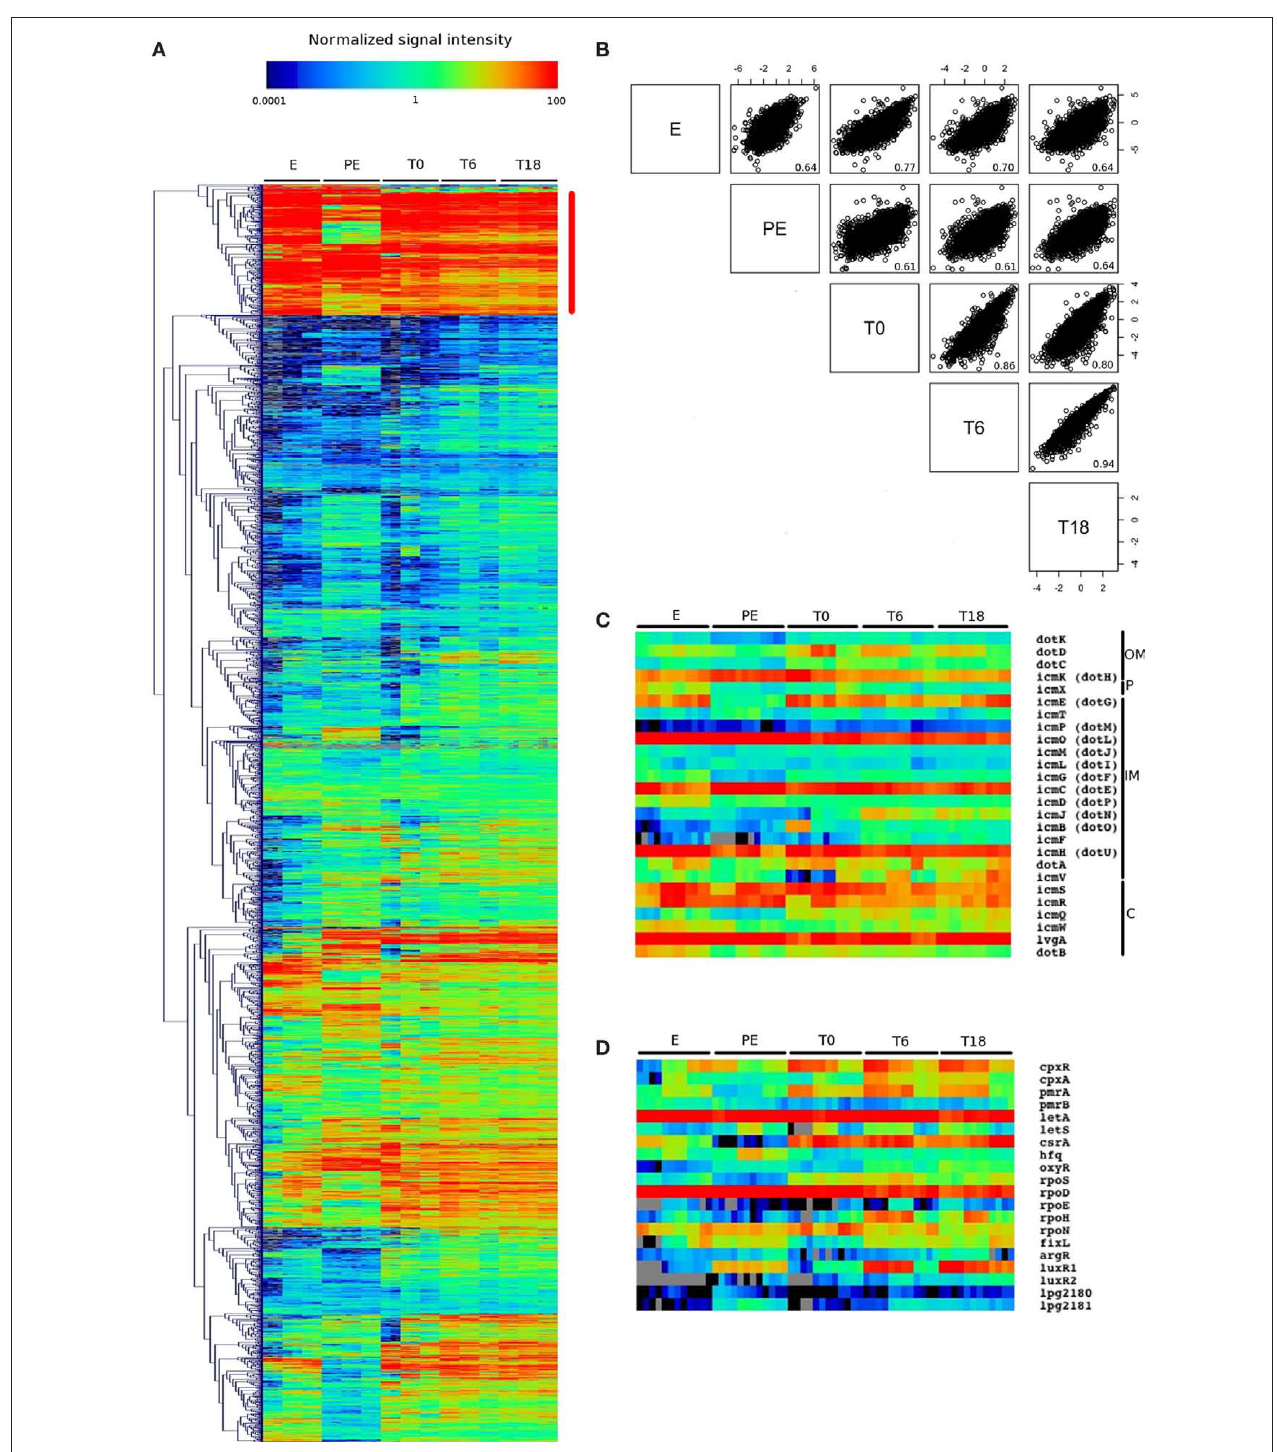
FIgURe 3 | analysis of the normalized signal intensities for each condition reveals similarity between in vivo conditions. (a) Hierarchical clustering of the normalized signal intensity of each replicate for each condition. The red line marks a cluster of genes highly expressed in all conditions tested. (B) The Bioconductor package was used to generate paired correlation matrix showing the degree of similarity between conditions. The correlation value is displayed in the lower right